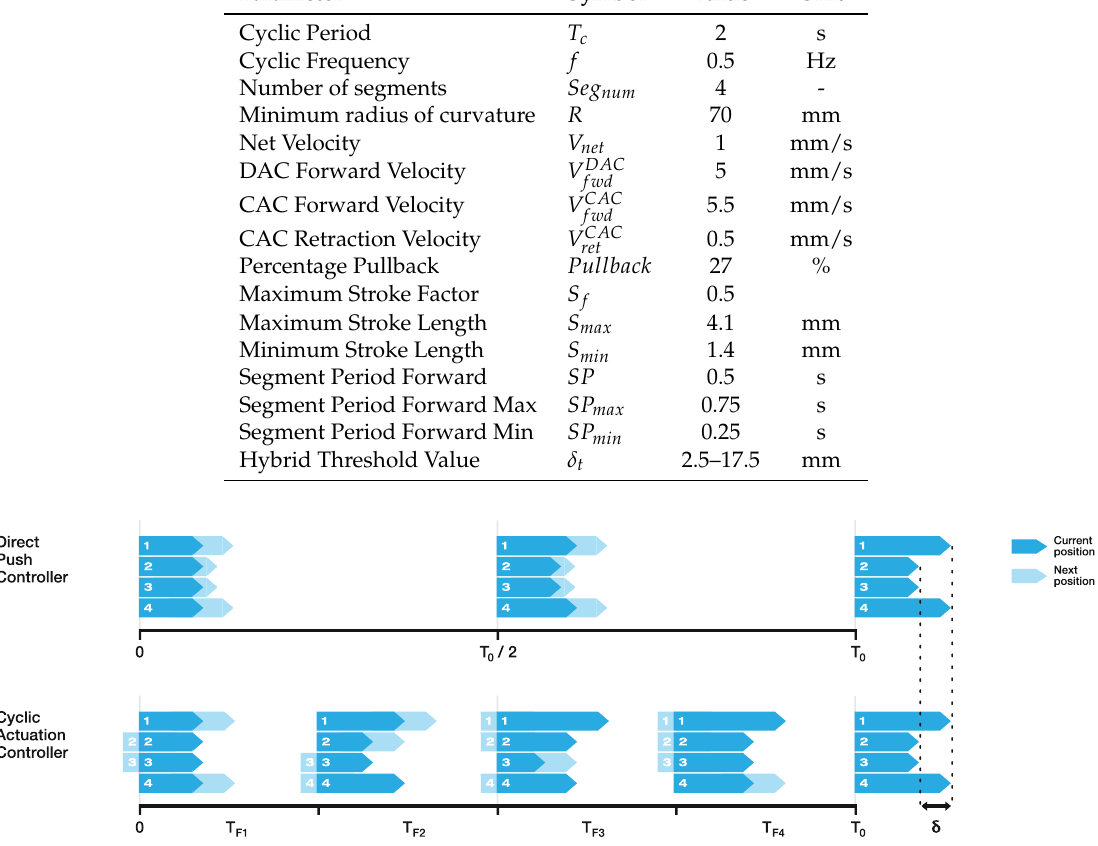
Figure 4. Comparison of the DAC and CAC when responding to a commanded offset, δ . T o refers to the time required to make the offset. T F _ i is the cyclic time period for which segment i moves either forward or